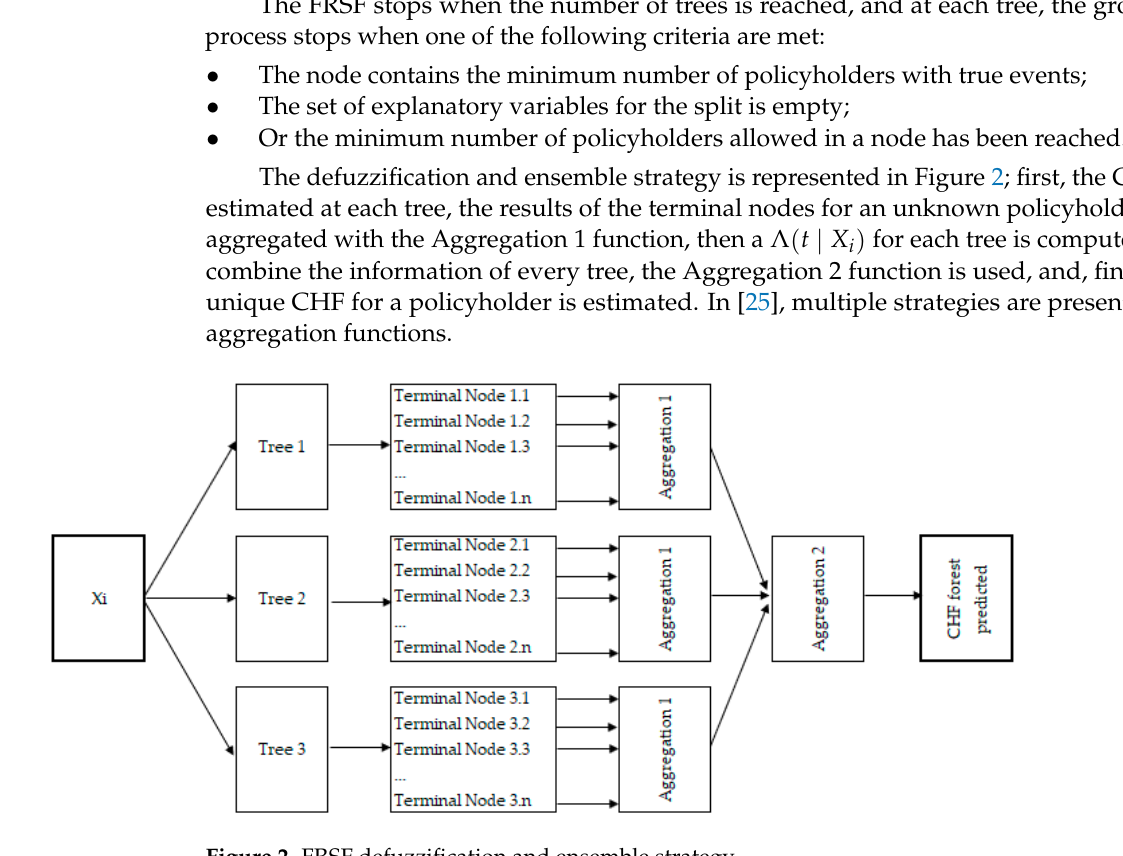
Figure 2. FRSF defuzzification and ensemble